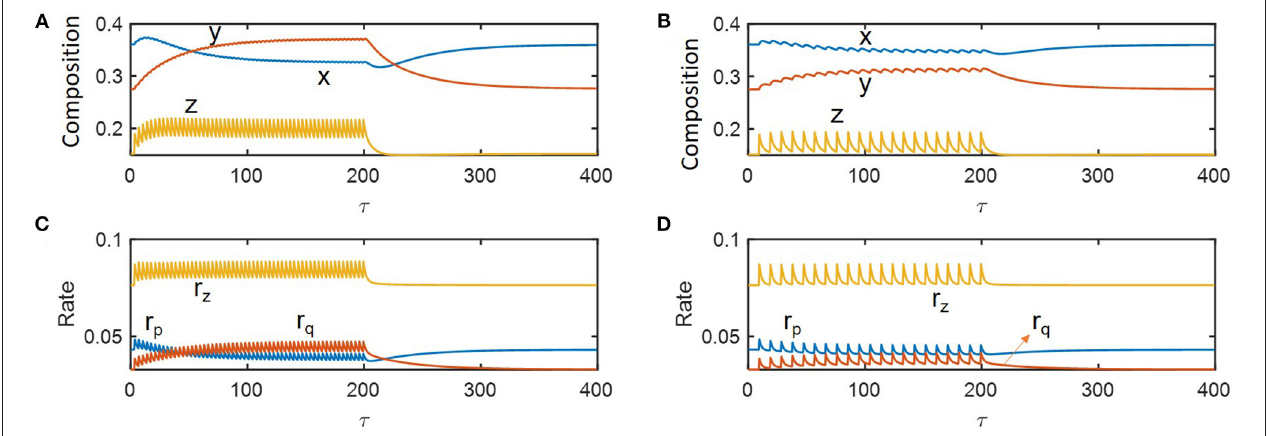
FIGURE 3 | Microbial response to periodic change of the inlet flow ( δ ) between 0.09 and 0.19: (A,C) perturbation interval of 3.5, and (B,D) perturbation interval of 9.5. The periodic perturbation was imposed over 0 ≤ τ ≤ 200 and released afterwards.